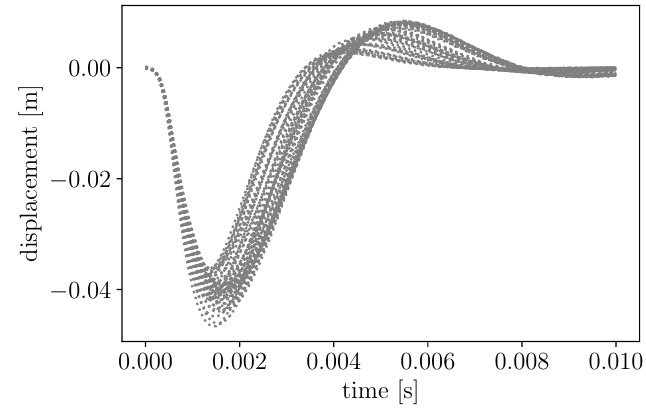
Figure 5. The mid-span vertical displacement of the 50